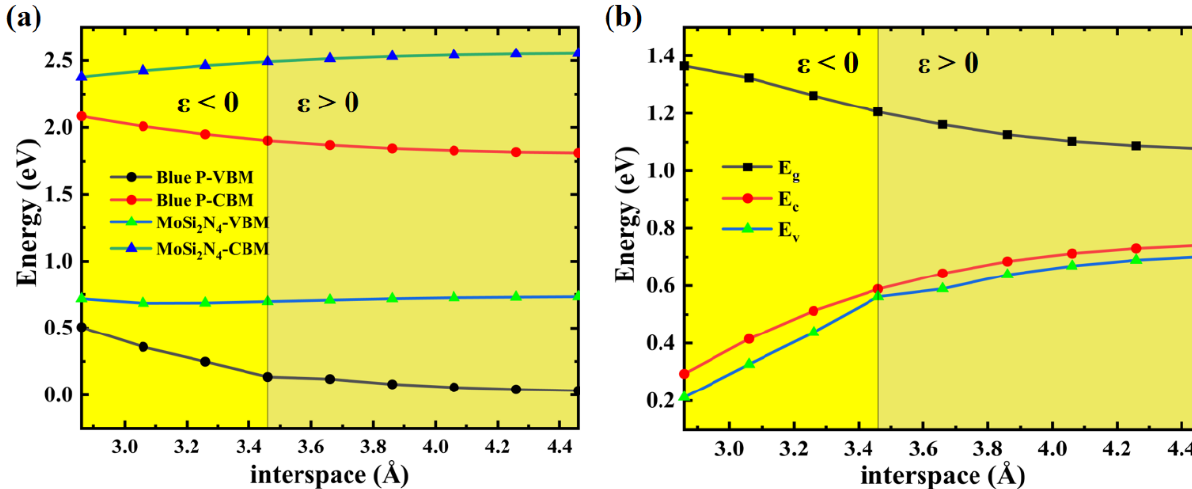
Figure 8. ( a ) Band alignment and ( b ) band offset together with bandgap as a function of interspace in the Blue P / MoSi 2 N 4 vdWH.